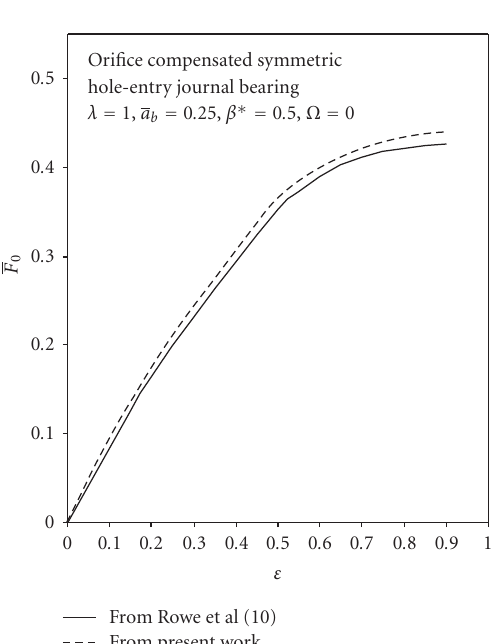
Figure 3: Variation of external load carrying capacity ( F 0 ) with eccentricity ( ε